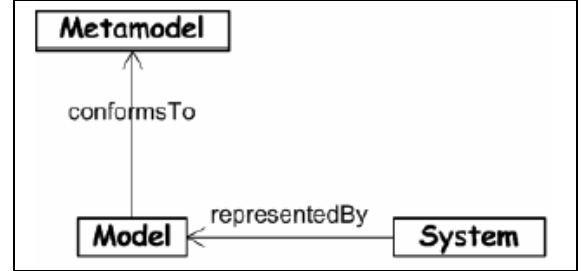
Fig. 1. Basics of model engineering